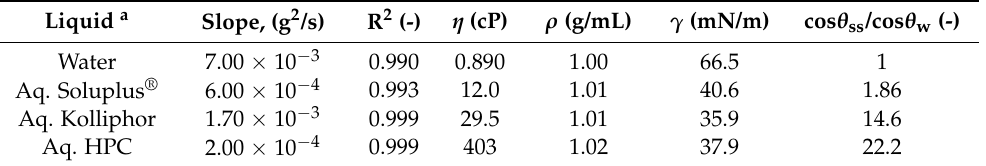
Table 5. Properties of various aqueous stabilizer solutions and the wetting effectiveness factor calculated from their penetration into packed GF powder during the Washburn